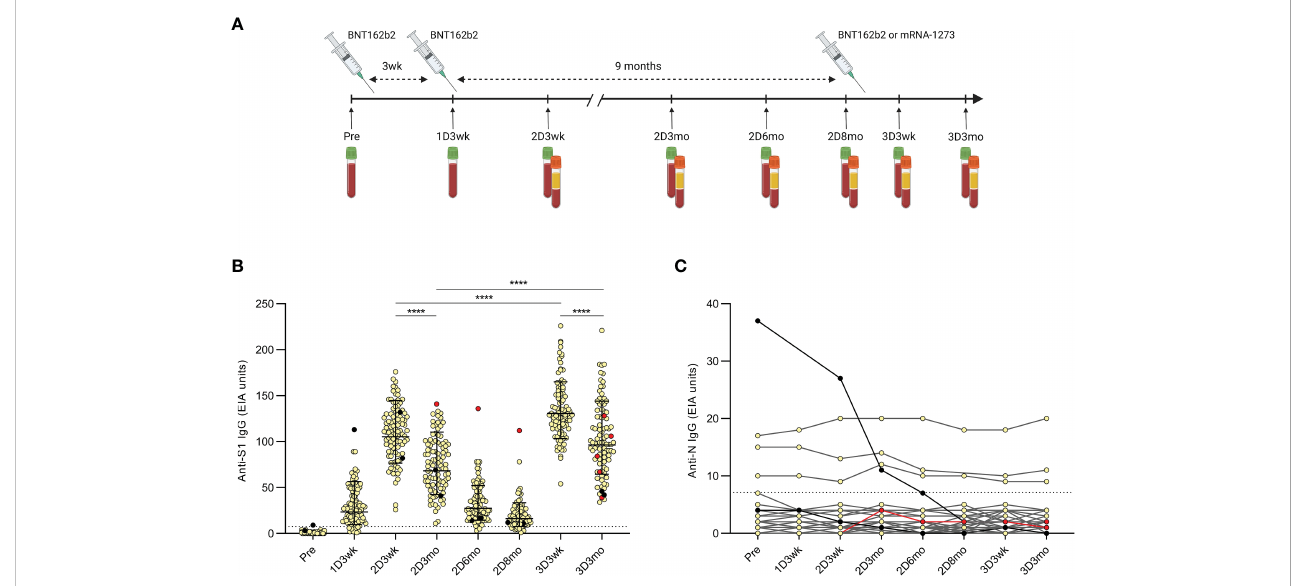
FIGURE 1 Timeline of the COVID-19 vaccinations and samplings of the HCWs and antibody levels after the second and third COVID-19 mRNA vaccine doses. (A) , Serum samples and peripheral blood mononuclear cells (PBMCs) were collected at regular intervals from health care workers (HCWs, n=100) vaccinated with two sequential doses of BNT162b2 (BioNTech-P fi zer) and a third mRNA vaccine dose of either BNT162b2 (n=46) or mRNA-1273 (Moderna; n=54). Sera were collected before the fi rst vaccination and up to three months after the third dose and PBMCs were collected from a proportion of the HCWs (n=32) at indicated time points. (B) , SARS-CoV-2 S1-speci fi c IgG antibody levels were measured with EIA from the serum samples collected before the fi rst vaccination (Pre; n=100), three weeks after the fi rst vaccination (1D3wk; n=99), three weeks (2D3wk; n=100), three months (2D3mo; n=99), six months (2D6mo; n=100), and eight months (2D8mo; n=85) after the second vaccine dose, and three weeks (3D3wk; n=100) and three months (3D3mo; n=94) after the third vaccine dose. Geometric means with geometric SDs are shown. Wilcoxon signed-rank test was used to analyze the statistical signi fi cance between time points (2D3wk vs 2D3mo; 2D3wk vs 3D3wk; 3D3wk vs 3D3mo; 2D3mo vs 3D3mo), and two-tailed p-values <0.05 were considered statistically signi fi cant. ****p<0.0001. (C) , SARS-CoV-2 N-speci fi c IgG antibody levels were measured with EIA from the same samples as the S1-speci fi c IgG antibodies. Black dots represent HCWs with a PCR-con fi rmed SARS-CoV-2 infection prior to the fi rst vaccination (n=2) and red dots represent HCWs with a breakthrough infection after the second vaccine dose (n=1) or after the third vaccine dose (n=4). Cut-off values are indicated with dashed